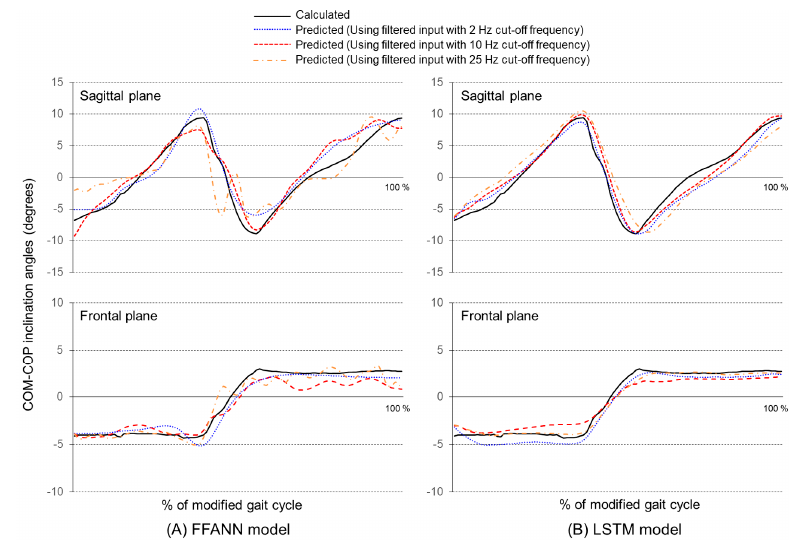
Figure 5. COM-COP inclination angle (IA) calculated using the 3D motion analysis system and predicted using the proposed neural network models.